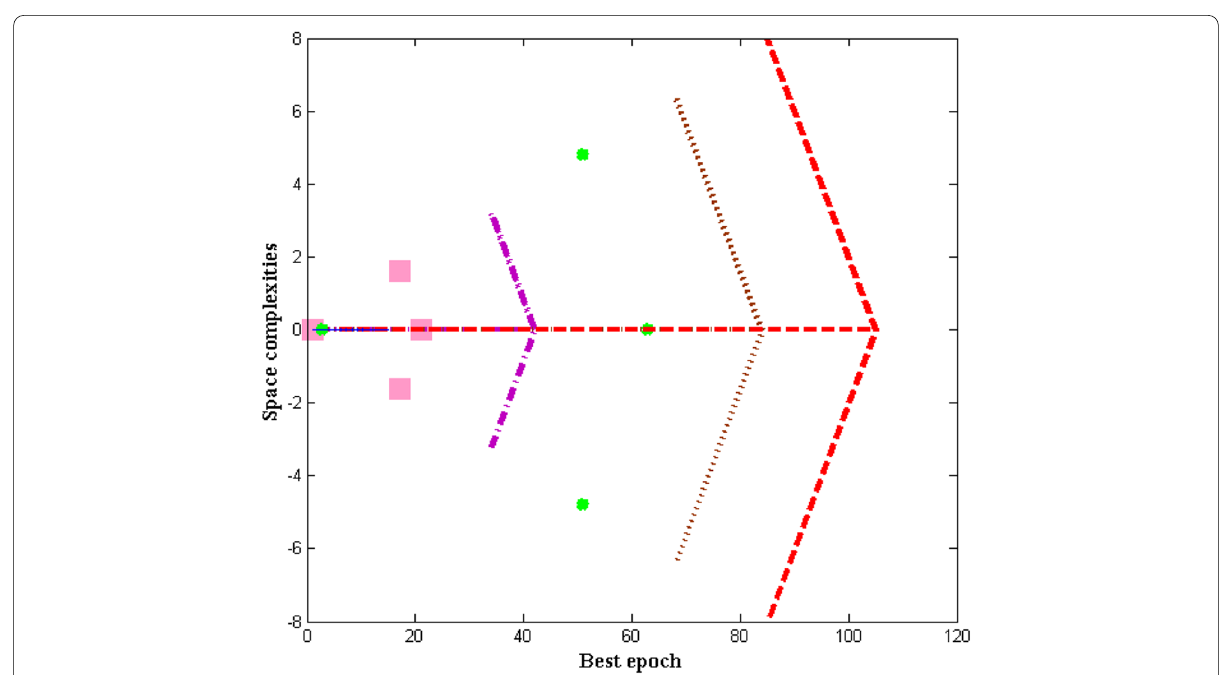
Fig. 9 Comparison of space